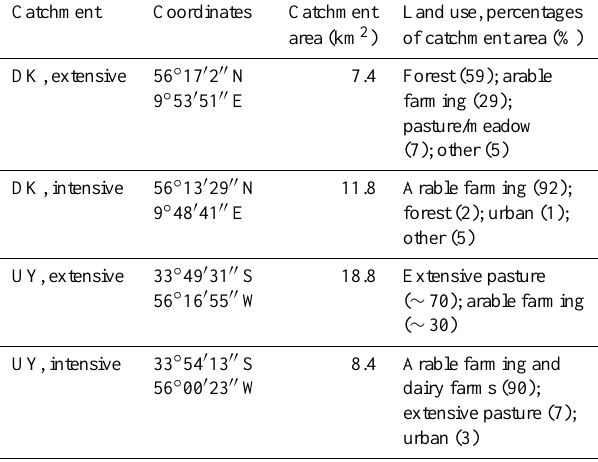
Table 1. Names, position of the sampled catchment (WGS 84) and farming type of the investigated catchments. DK: Denmark, UY: Uruguay, extensive: extensive farming, intensive: intensive farming.